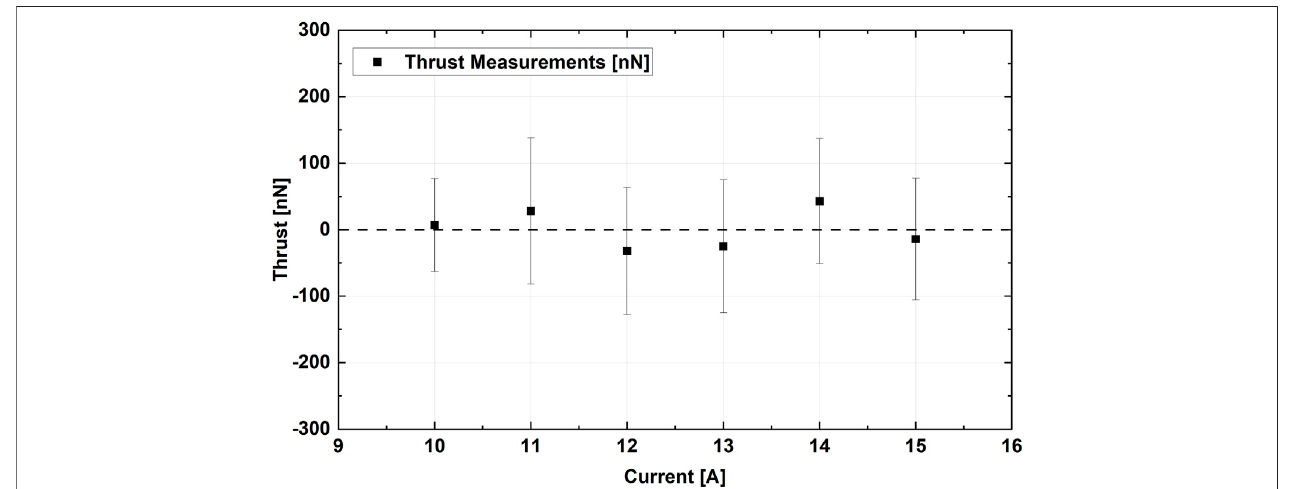
FIGURE 12 | Thrust measurements of the enhanced BSCCO setup with magnet rings with increasing electric current levels between 10 and 15 A in steps of 1 A. Each data point represents an average of 2-3 consecutive measurements at equal operating parameters.